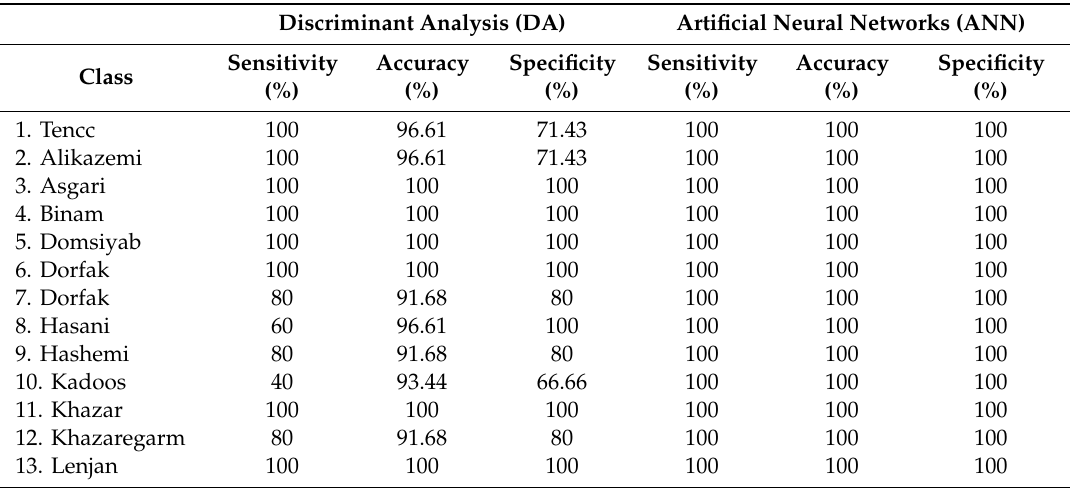
Table 4. Performance criteria for the two classifiers in the classification of Brown rice varieties.